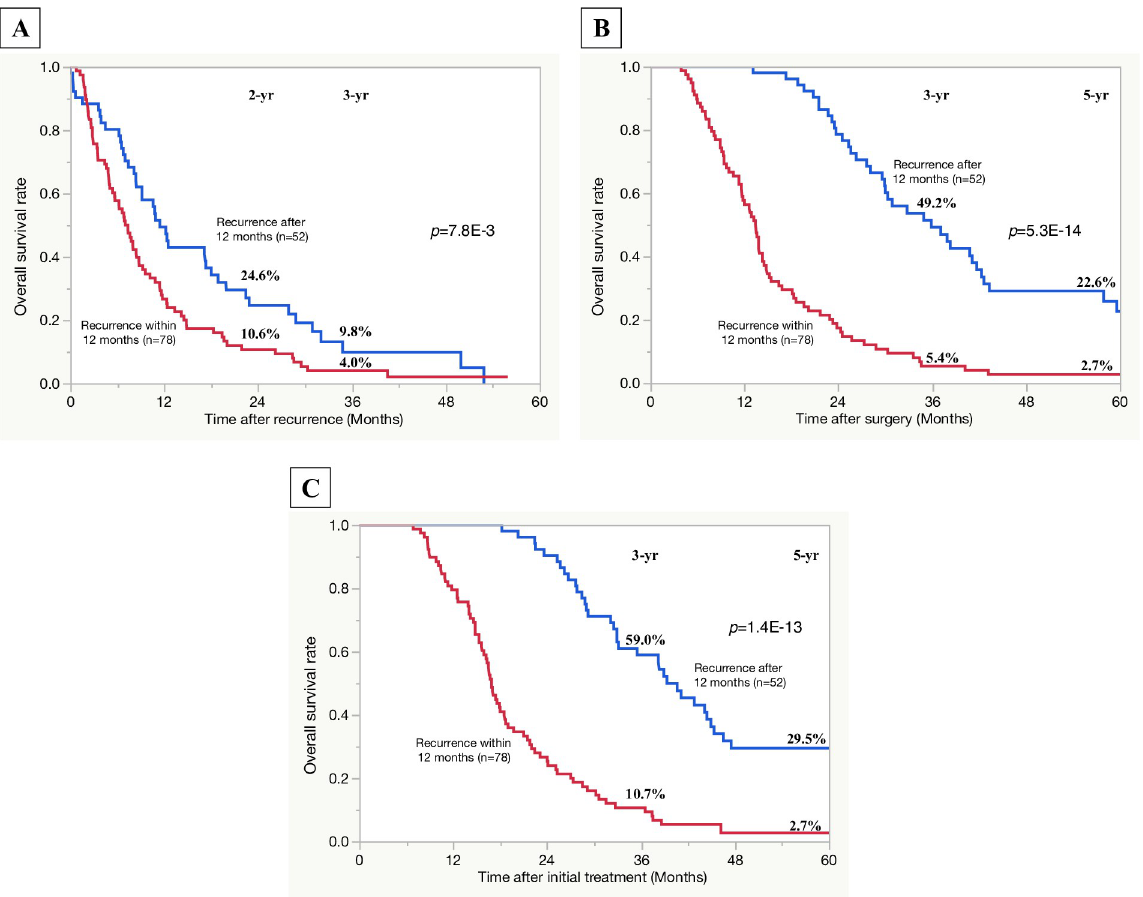
Fig 1. Comparison of survival curves based on the period of recurrence development from surgery (recurrence after 12 months vs. recurrence within 12 months). A: post-recurrence survival rates; B: overall survival rates after surgery; C: overall survival rates after initial treatment, p value was expressed in exponential